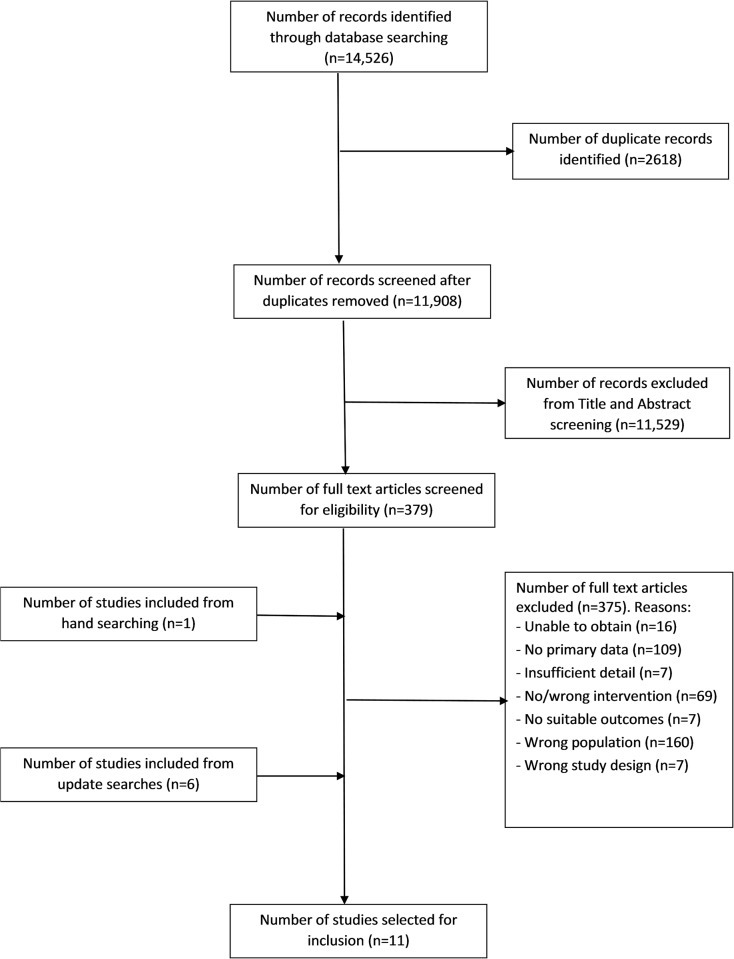
PRISMA flow diagram.